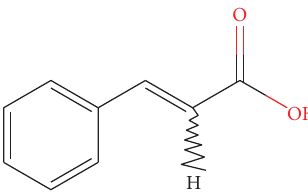
Figure 1: The molecular structure of cinnamic acid.